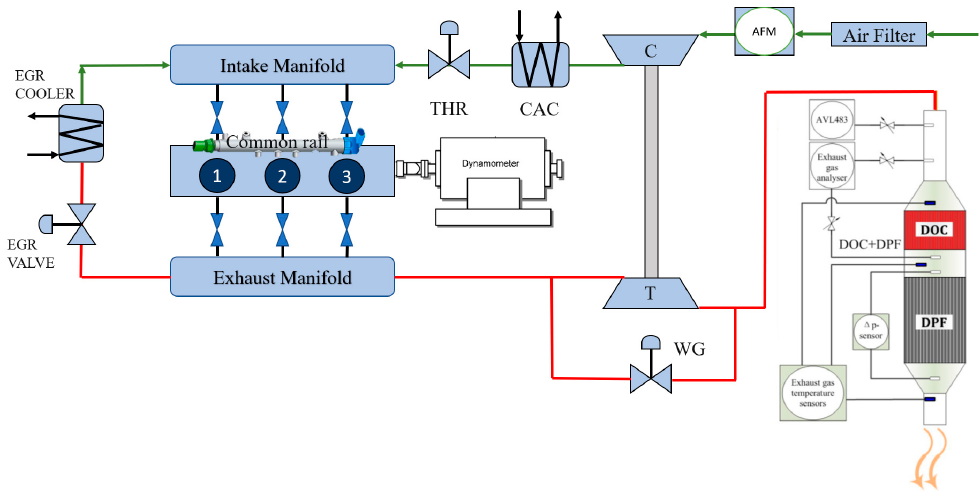
Figure 3. Kohler KDI 1903 engine: experimental setup layout and engine schematic.